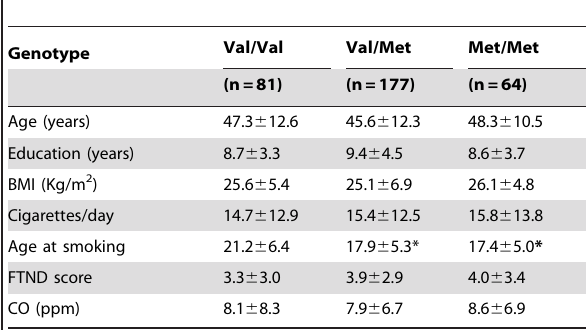
Table 3. Smokers characteristics subgrouped according to BDNF Met66Val